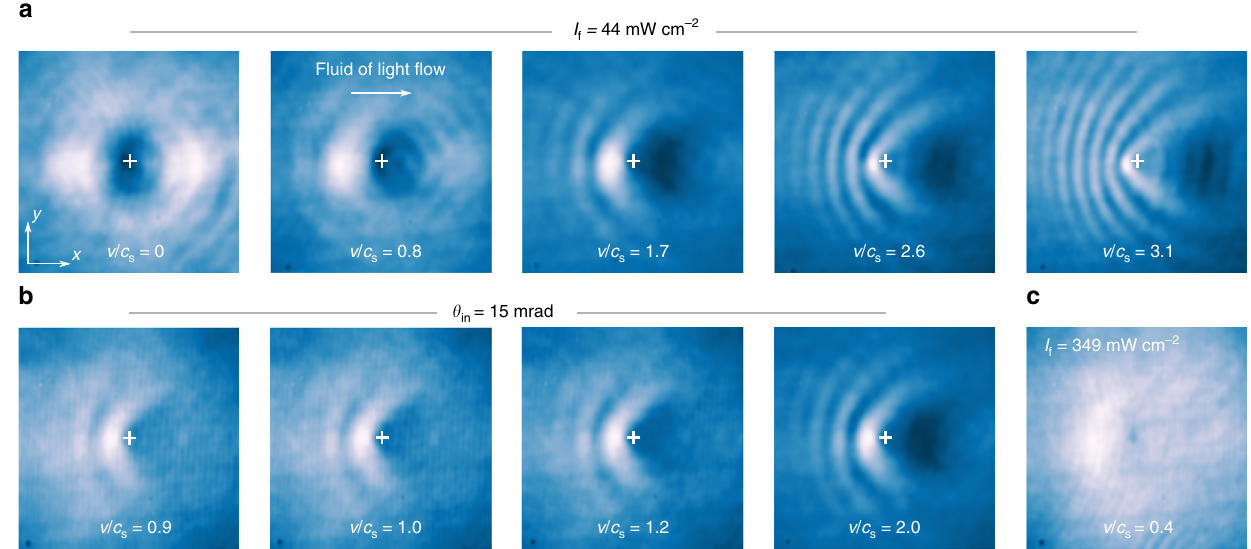
Fig. 2 Spatial distribution of the output intensity of the fl uid of light for various input conditions. The fl uid of light fl ows from left to right. The white crosses at the center of the images indicate the position of the obstacle. Each image is 330 × 330 μ m 2 . a At a fi xed input intensity I f , the input angle θ in of the beam creating the fl uid of light is tuned to vary the Mach number v / c s from 0 to 3.1. b Similarly, at a fi xed input angle θ in , I f is progressively decreased to change v / c I fl uid of light is clearly in the super fl uid regime at v / c = 0.4. The remaining lack of uniformity upstream from the s from 0.9 to 2.0. c For large f , the s obstacle is attributed to propagation losses due to linear Fig. 1c, a local drop of the optical index is photo-induced by a narrow beam in the crystal and creates the obstacle. Simulta- neously, a second, larger monochromatic beam is sent into the crystal and creates the fl uid of light. The propagation of the fl uid- of-light beam in the paraxial approximation is ruled by a two- dimensional Gross-Pitaevskii-type equation (also known as a nonlinear Schrödinger-type equation):